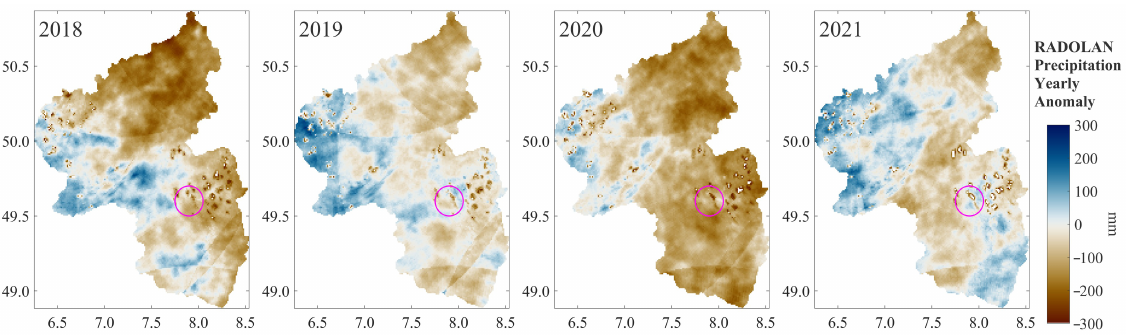
Figure 2. Precipitation Anomaly in RLP for the years 2018 to 2021 in comparison to the mean (2007 to 2021), the Donnersberg area is circled. Data source: German Weather Service DWD [31].